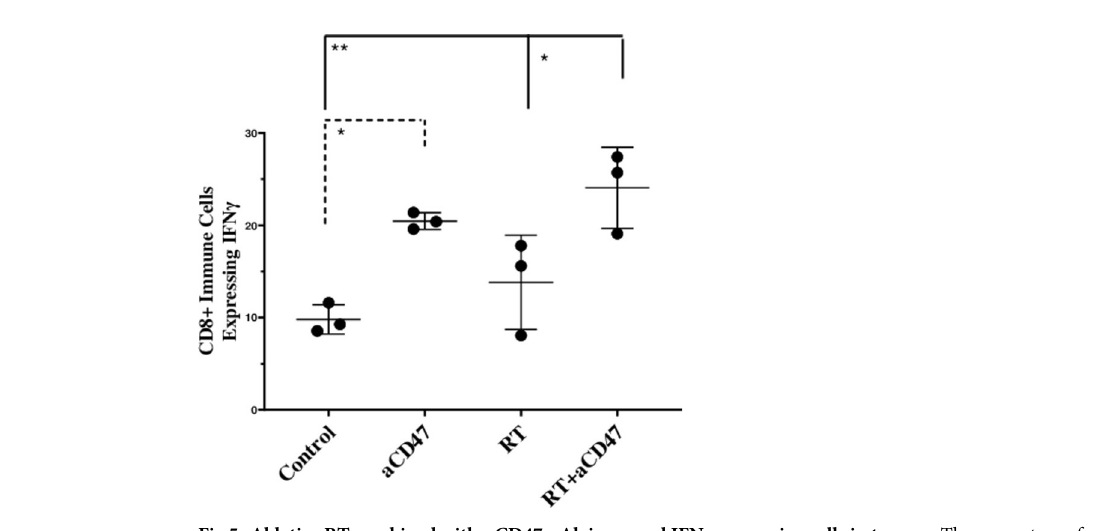
PLOS ONE | https://doi.org/10.1371/journal.pone.0273547 August 26,